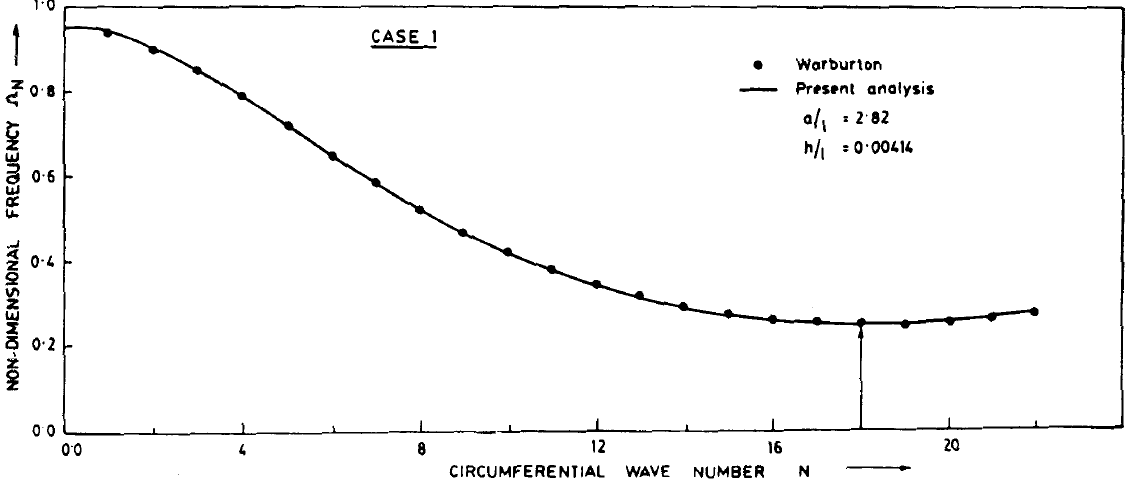
Fig. 7. Comparison of natural frequencies obtained by present analysis with those obtained from Warburton’s method (Case 1).